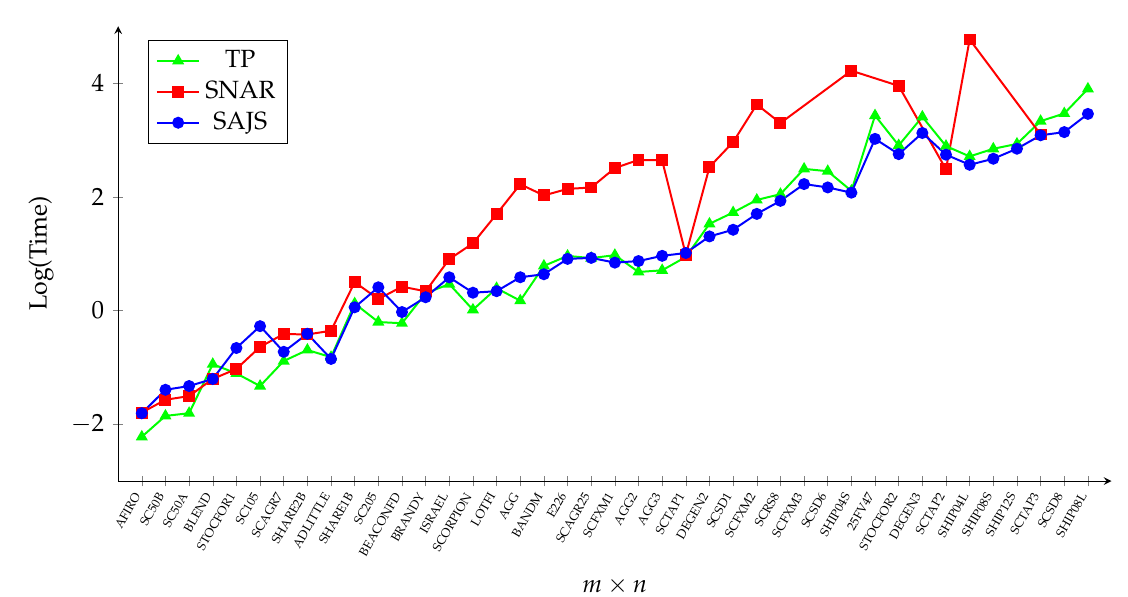
Figure 7. The comparison of SAJS, TP, and SNAR using the average wall-clock time—netlib